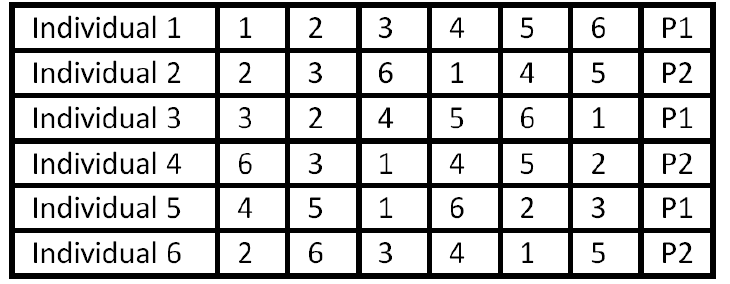
Figure 6. Distribution of mutated segments in the processes of the MiniGrid.